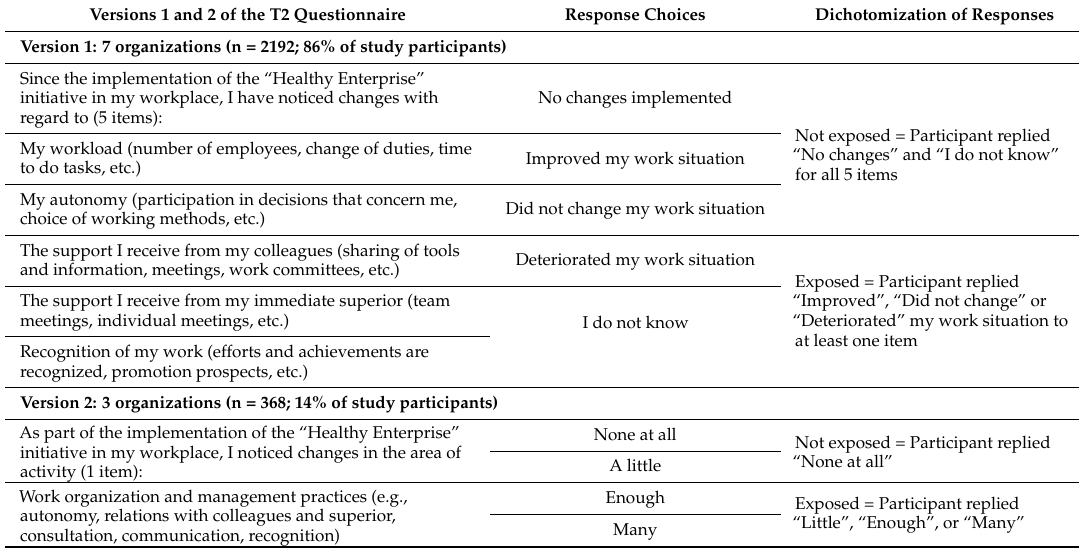
Table A1. Items used to assess participants’ perceived exposure to interventions in the Management Practices area of the QHES in versions 1 and 2 of the T2